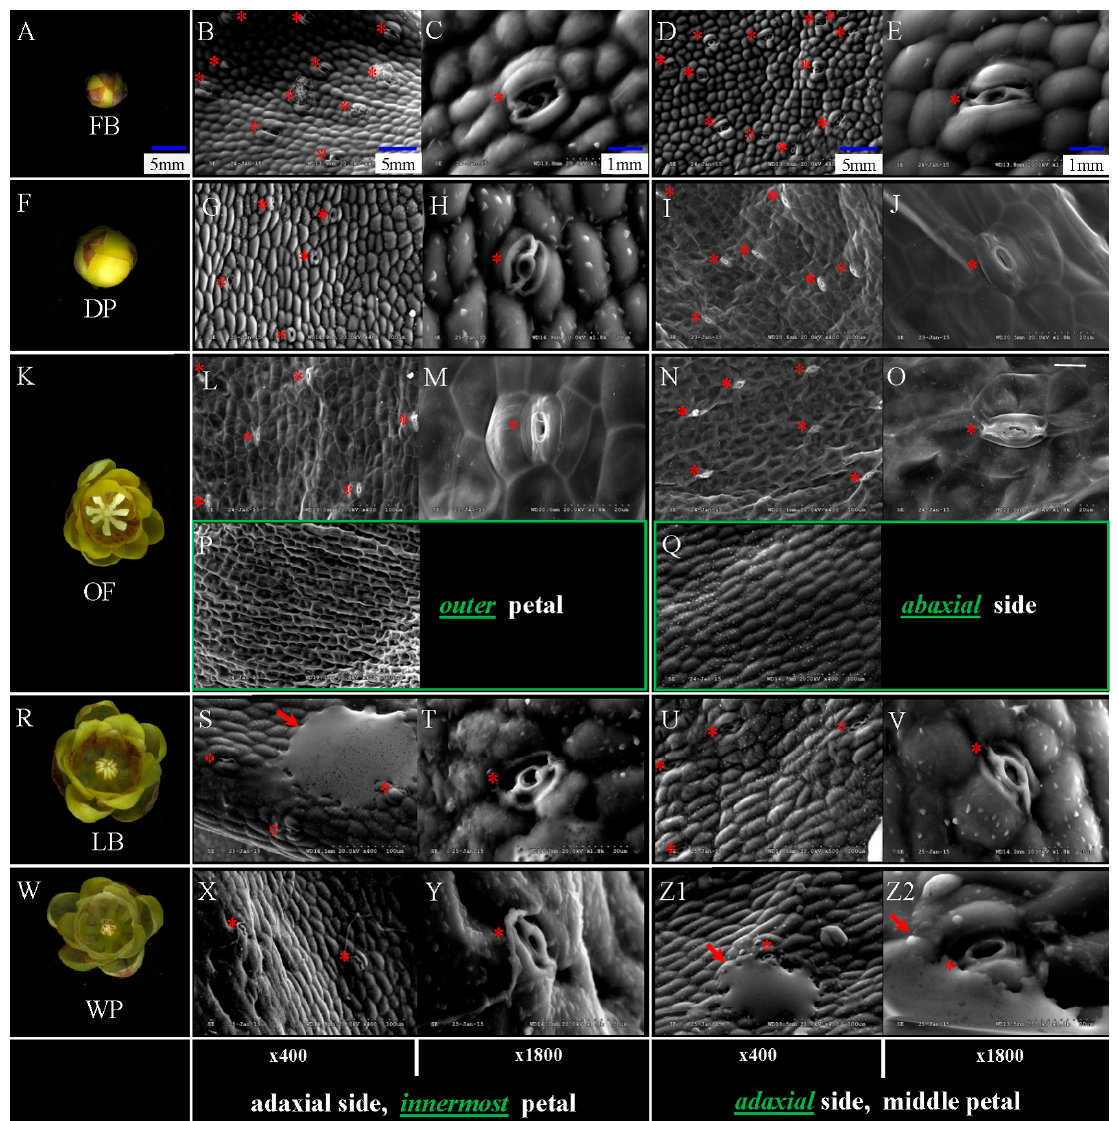
Figure 1. Morphology of the surface of petal glands on different stages in the Chimonanthus praecox by SEM. ( A , F , K , R , W )floral meristem of five different developmental stages (FB, DP, OF, LB, and WP); ( B , C ; G , H ; L , M ; S , T ; X , Y ) nectaries on adaxial side of innermost petals in five different developmental stages. ( D , E ; I , J ; N , O ; U , V ; Z1 , Z2 ) nectaries on the adaxial side of middle petals in five different developmental stages. ( B , D , G , I , L , N , S , U , X , Z1 ) surface of the glandular tissue, showing the nectary stomata (red asterisk). ( C , E , H , J , M , O , T , V , Y , Z2 ) close-up of the nectary stomata. ( P , Q ) (in green box) no nectary distribution on adaxial side of outer petal and abaxial side of middle petals in OF stages. Scale bar is the same in ( A , F , K , R , W ); ( B , D , G , I , L , N , P , Q , S , U , X , Z1 ); and ( C , E , H , J , M , O , T , V , Y , Z2 ), respectively. Red arrow shows the substance of floral scent. The magnification was × 400 (left) and × 1800 (right), respectively.